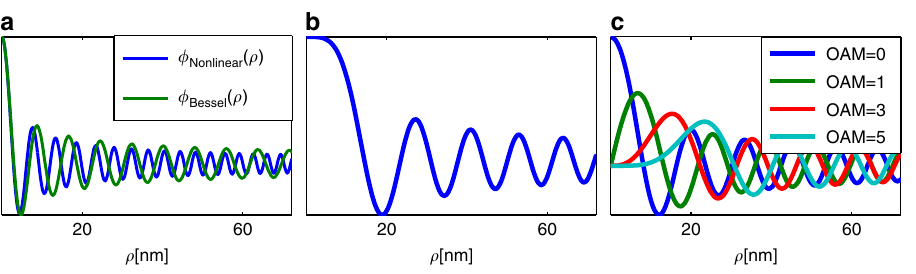
Fig. 1 Radial part of the shape-invariant wavefunctions of multi-electron beams. a Radial wavefunction ( ϕ ( ρ )) of the beam with zero OAM ( blue ), compared with the Bessel function which is the corresponding non-diffracting single-electron beam. b The unique over-wide radial wavefunction obtained for k T = 0, which does not allow OAM, and does not have a corresponding non-diffracting single-electron beam. c Radial wavefunctions of multi-electron beams carrying OAM = 0, 1, 3, 5 ( blue , green , red and cyan ,